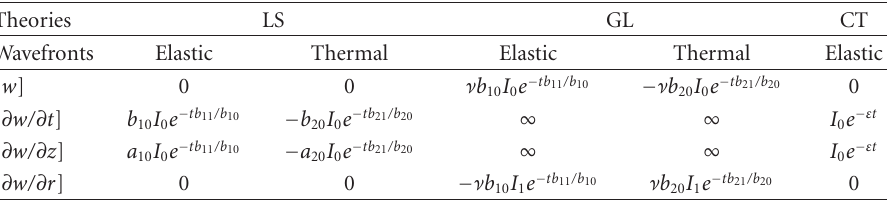
Table 4.3. Propagating discontinuities in w and its first